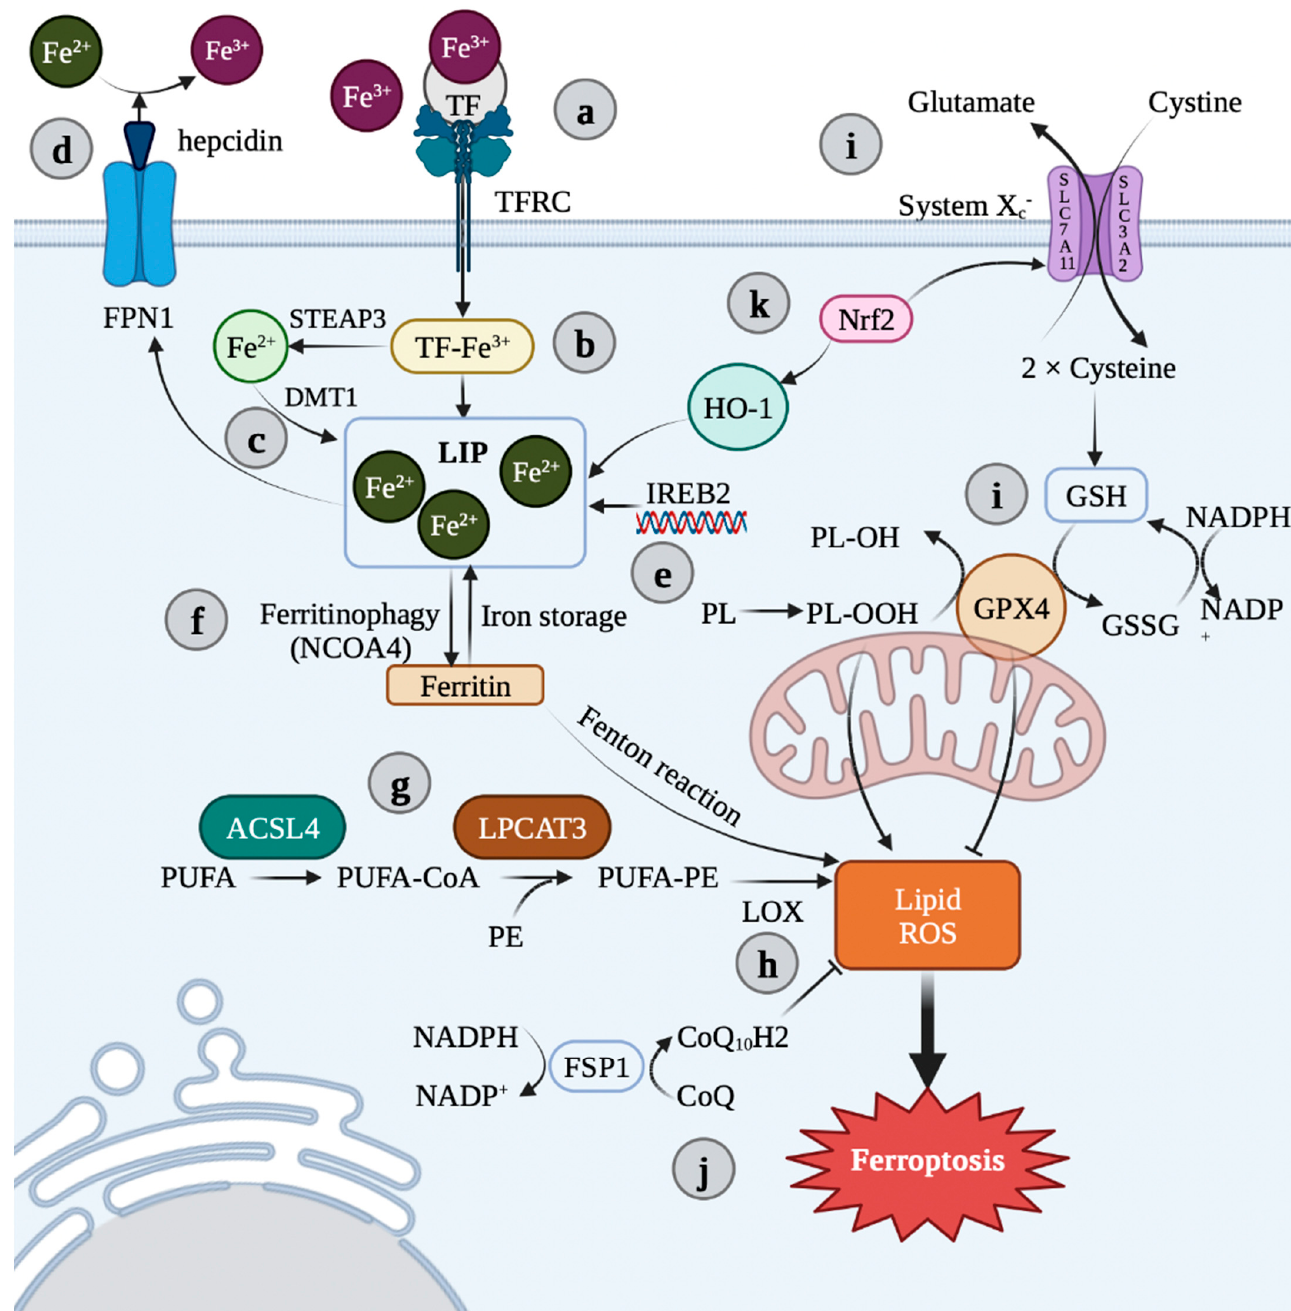
Figure 1. Overview of ferroptosis pathways. ( a ) TFRC is bound to TF and two Fe 3+ , which then enter the cell via endocytosis. ( b ) In endosomes, Fe 3+ is reduced to Fe 2+ via STEAP3. ( c ) Fe 2+ can then be stored as ferritin or act in an active loose state known as a “liable iron pool” (LIP) by DMT1. ( d ) Fe 2+ can be released into the plasma via ferroportin (FPN), while hepcidin can bind to FPN to inhibit Fe 2+ release and regulate iron homeostasis. ( e ) IREB2 is also a key regulator of iron content. ( f ) Ferri- tinophagy and LIP contribute to iron load, and excess iron is the cofactor of LOX. ( g ) ACSL4 and LPCAT3 are involved in the manufacture and modification of PUFA-PE containing polyunsaturated fatty acid in the cell membrane. ( h ) LOX (mainly LOX-15) mediates the peroxidation of PUFA-PE to conduct the ferroptosis axis. ( i ) Ferroptosis is controlled by two major regulatory systems, namely, the transporter system X c − , which is composed of SLC3A2 and SLC7A11, and the GSH/GPX4. ( j ) In addition, there are GSH-independent antioxidant pathways, such as the CoQ 10 axis. The FSP1 in the plasma membrane showed oxidoreductase activity. It reduces the coenzyme Q and decreases the accumulation of L-OOH. ( k ) The Nrf2/HO-1 axis can promote the increase of Fe 2+ by catabolizing